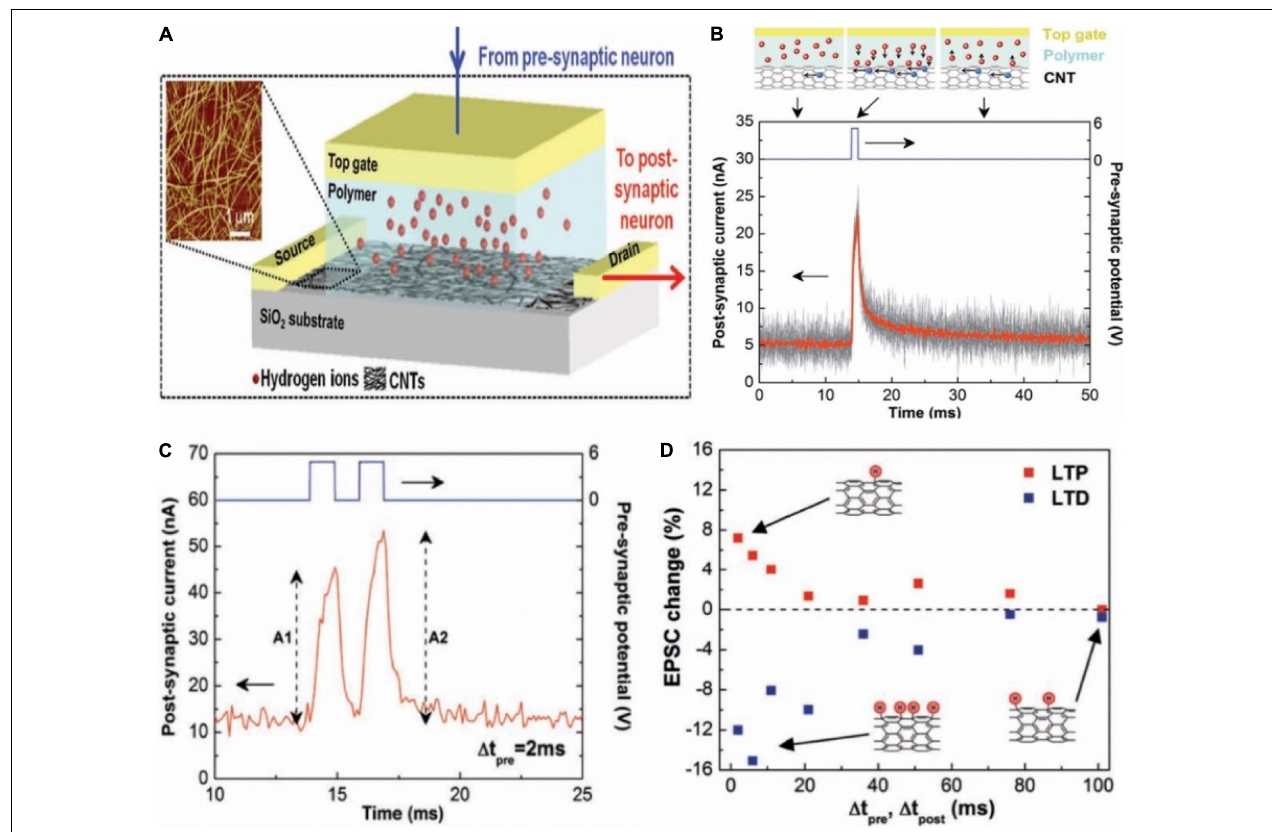
FIGURE 7 | (A) The schematic diagram of a carbon nanotube (CNT) synapse, which shows the transistor-like structure of the CNT synapse with a cell containing hydrogen ions in the electrolyte integrated in its gate. Inset is the AFM of a random CNT network. (B) EPSC triggered by the pre-synaptic spikes. (C) EPSCs triggered by a pair of pre-synaptic spikes. (D) The changes of EPSC amplitudes in the synaptic device with (cid:49) t pre and (cid:49) t post under the LTP and LTD imitations. Insets illustrate the CNT hydrogenation after the LTD imitation (bottom, left), the dehydrogenation after the LTP imitation (top), and no remarkable change after the LTP or LTD imitations (bottom, right) (adapted from Kim et al.,